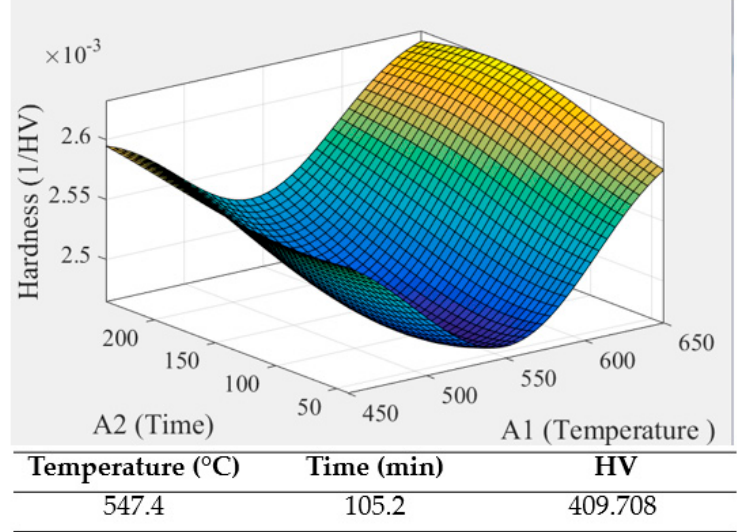
Figure 12. The optimal parameter for annealing. Table 10. The actual value of the optimal parameter.